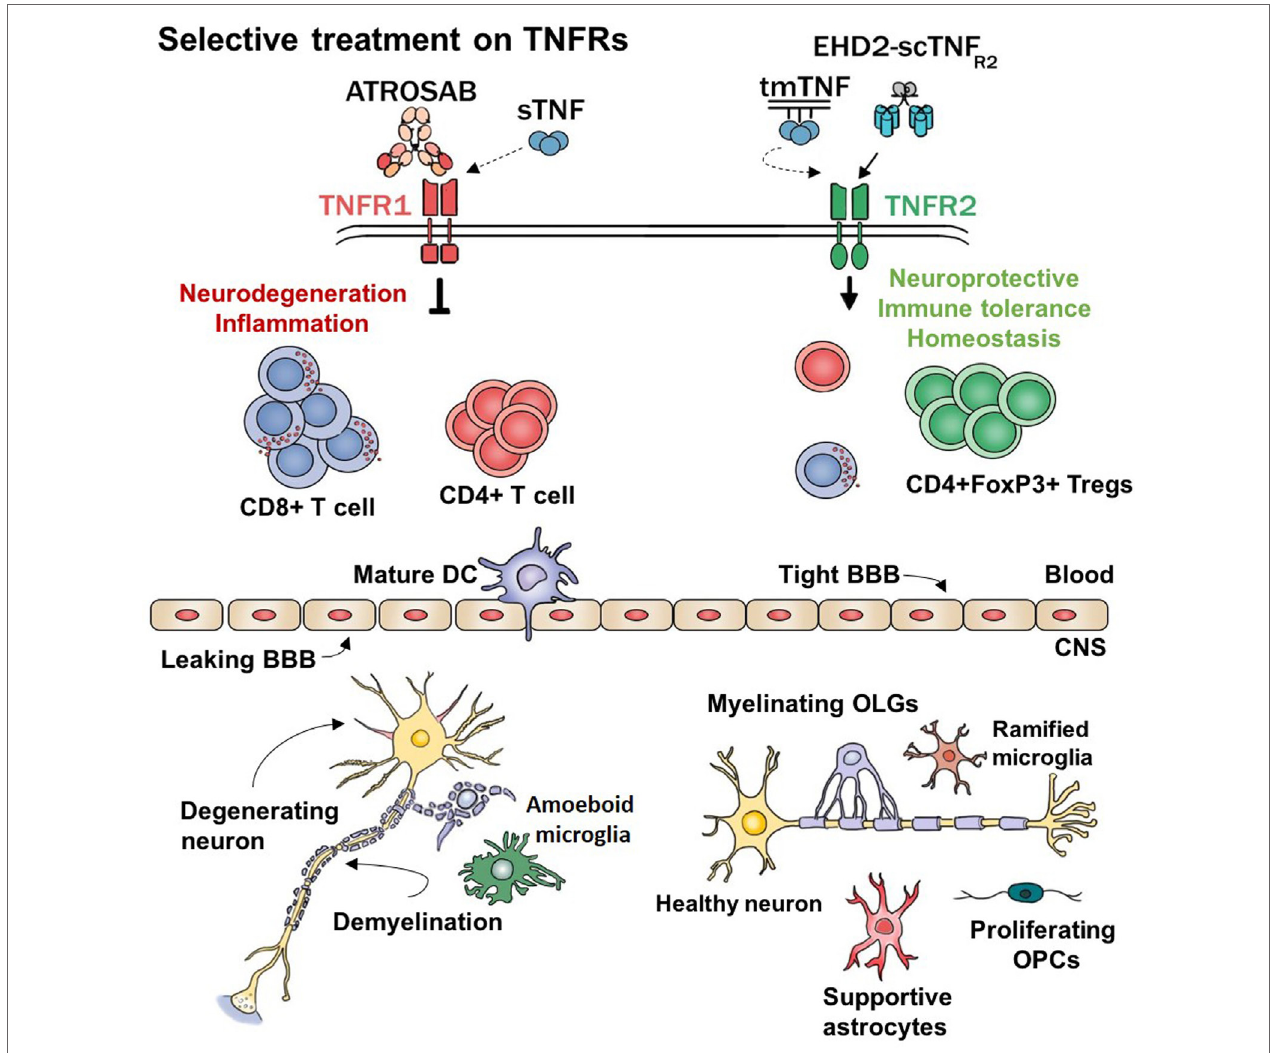
FigURe 1 | Hypothetical working model. TNF α and its receptors regulate major functions of several cell types. This model represents the expected effects of selectively modulating TNF–TNFRs signaling. sTNF, soluble TNF; tmTNF, transmembrane TNF; ATROSAB, TNFR1 antagonistic antibody; EHD2-scTNFR2, TNFR2 agonist; CD8 + T cell, cytotoxic T cells; CD4 + T cells, helper T cells; DC, dendritic cell; BBB, blood–brain barrier; Tregs, regulatory T cells; CNS, central nervous system; OPCs, oligodendrocyte’s precursor cells; OLGs, oligodendrocytes; TNF α , tumor necrosis factor